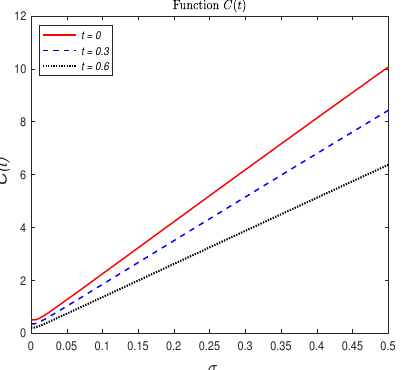
Figure 9. Time evolution of European call option price C ( t ) as a function of σ